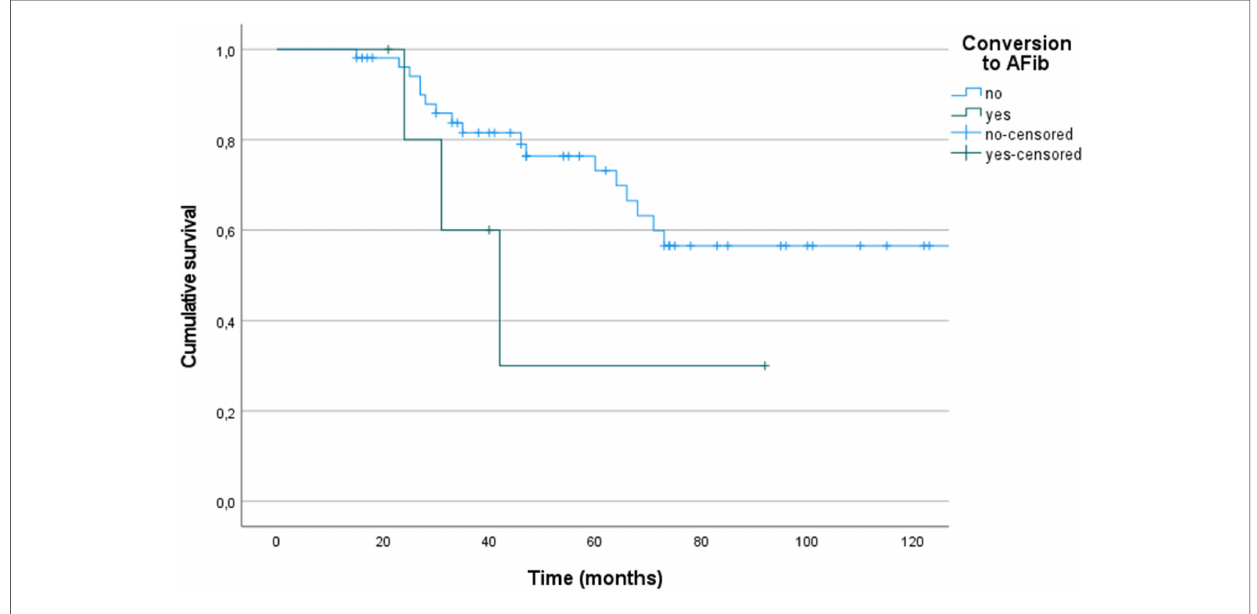
FIGURE 4 Kaplan – Meier plots (+=censored data) for survival of patients with sinus rhythm ( n =48) and atrial fi brillation (AFib, n